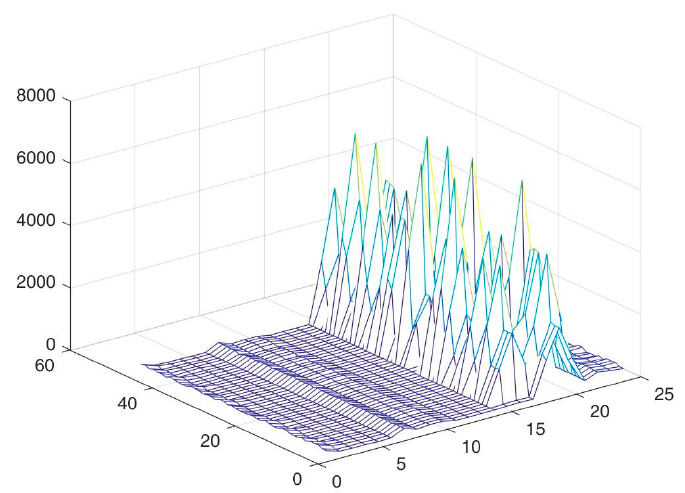
Figure 13. All cluster centers of mass data.